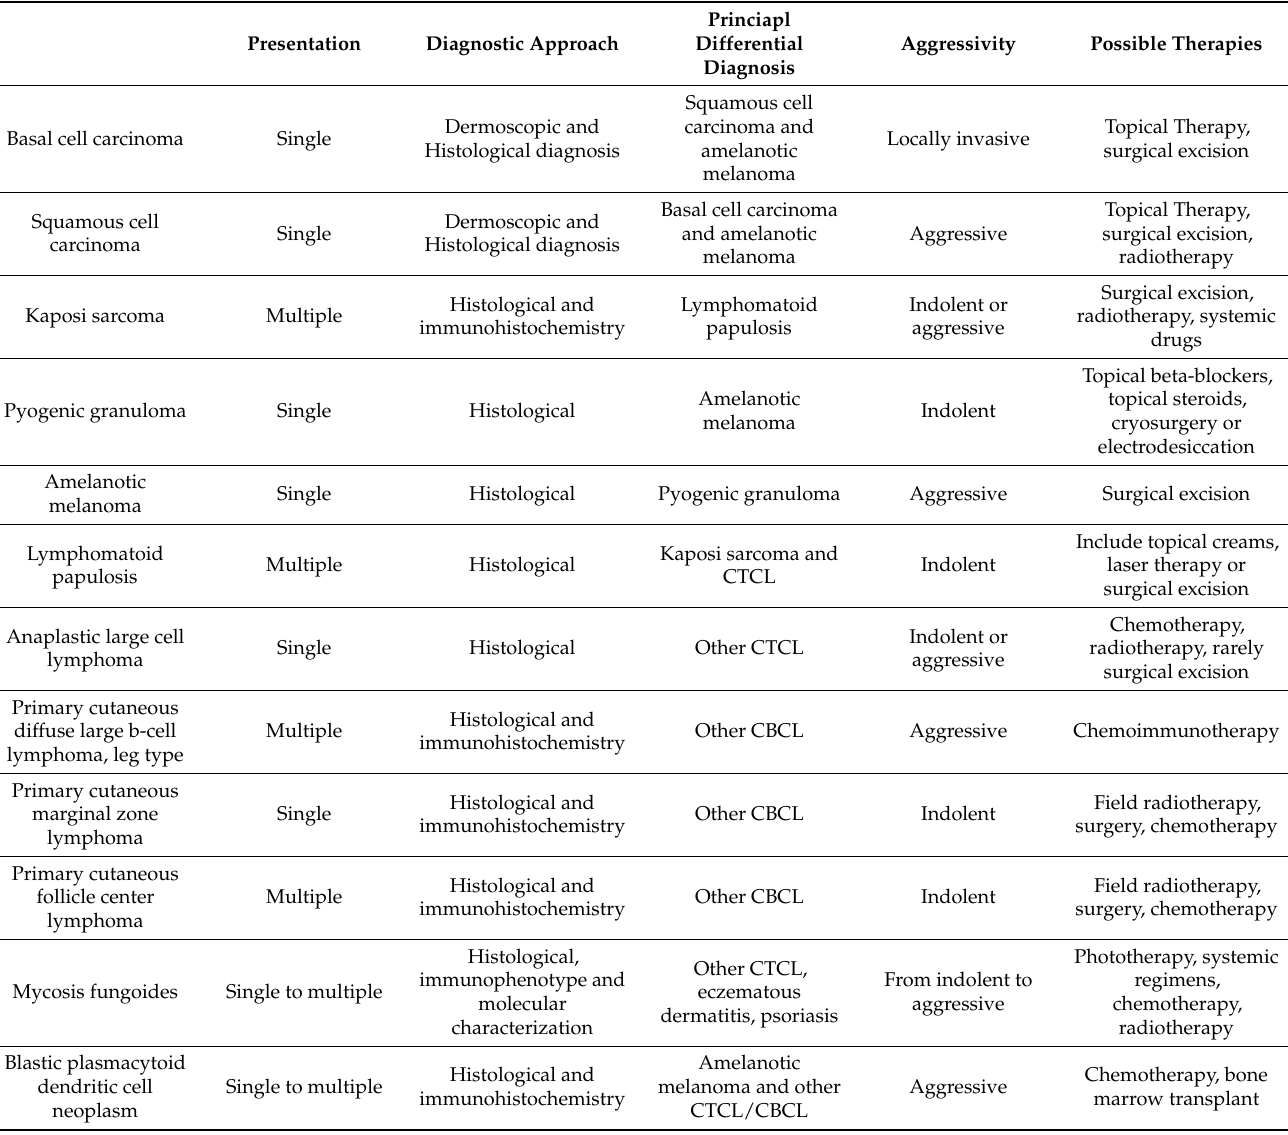
Table 1. Rapid chart of clinical characteristics, diagnostic criteria, differential diagnosis, prognosis and treatment of the main neoplastic, violaceous lesions of the